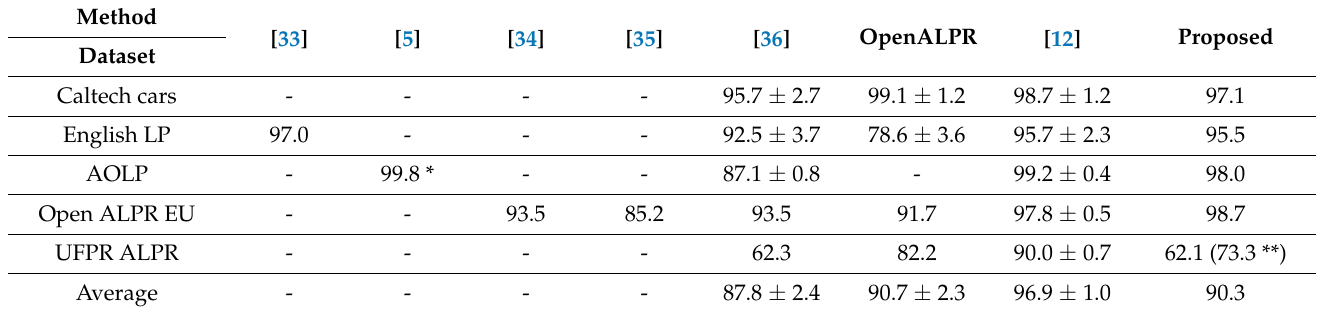
Table 10. ALPR comparison to other methods across all datasets used. * The first two stages of the pipeline were skipped. ** When considering the UFPR ALPR dataset as a video.